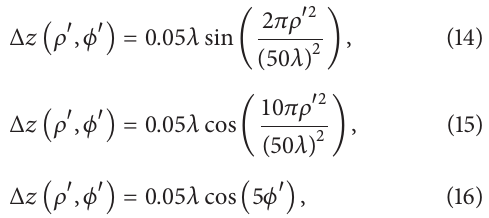
Figure 6: Far field pattern comparisons of the extended formula with the previous one under deformation